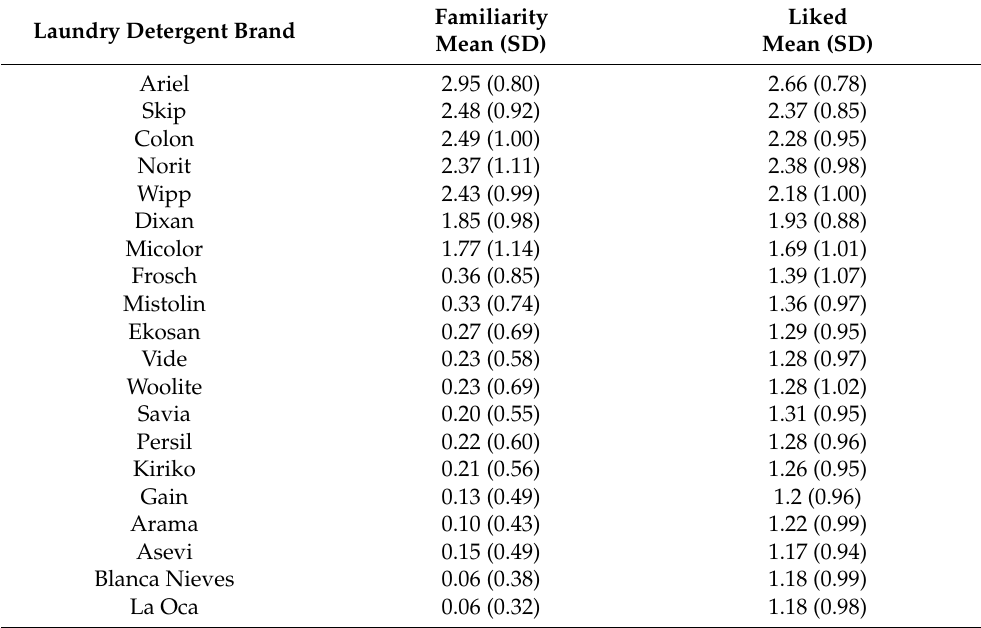
Table 2. Descriptive statistics on familiarity and level of being liked for each brand from the laundry detergent